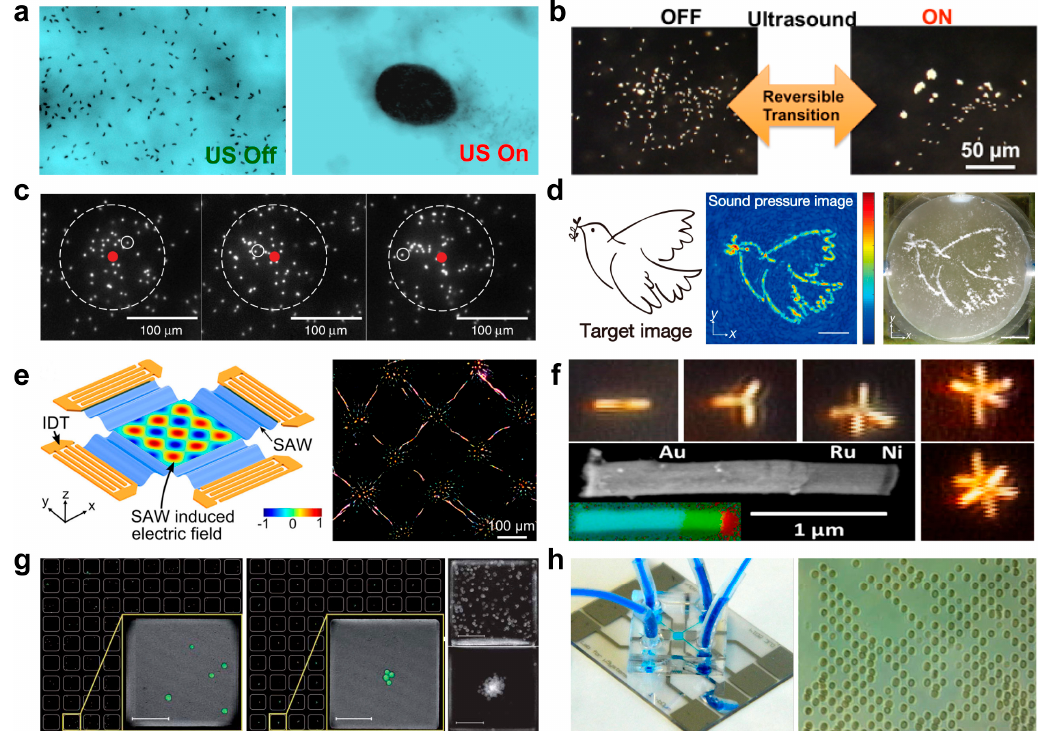
Figure 5. Ultrasound induced swarming and assembly of micro/nanoparticles. ( a ) Ultrasound swarming of Au-Pt catalytic nanowires (reproduced from [71]). ( b ) Reversible swarming behavior of Au-Ru microrods (reproduced from [72]). ( c ) Acoustic trapping of Janus Pt/PS particles (reproduced from [73]). ( d ) Holograms for acoustics (reproduced from [11]). ( e ) Tunable nanowire patterning using standing surface acoustic waves (reproduced from [74]). ( f ) Self-assembly of nanorod motors into geometrically regular multimers and their propulsion by ultrasound (reproduced from [75]). ( g ) Ultrasound-controlled cell aggregation in a multi-well chip (reproduced from [76]). ( h ) Surface acoustic wave for assembly of single cell (reproduced from [77]).